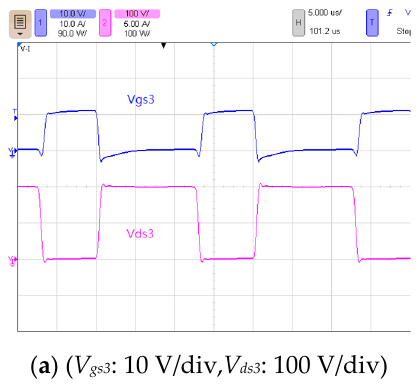
Figure 12. Measured waveforms under Stage 2 at full load: ( a ) switch S 1 waveform, ( b ) switch S 2 waveform, ( c ) primary-side current waveform of transformer, ( d ) charging inductor current waveform, ( e ) switch S 3 waveform, ( f ) switch S 4 waveform, and ( g ) secondary-side current waveform of transformer.